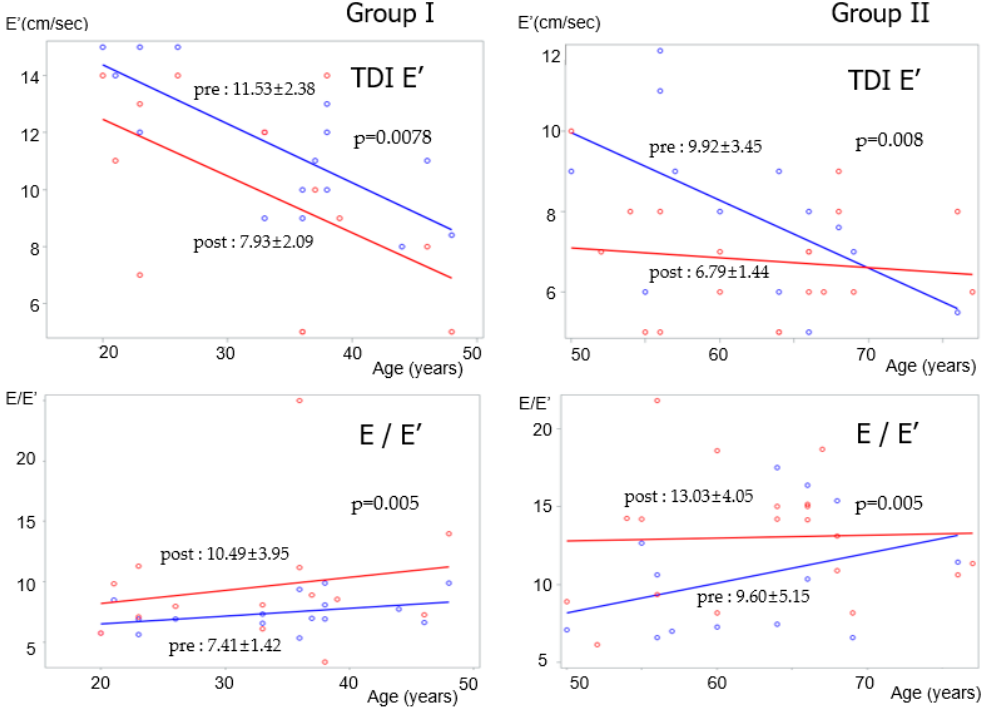
Figure 1. TDI E’ and E / E’ data as a function of age before and after atrial septal defect closure in Group I (N = 18) and Group II (N = 20). TDI: tissue Doppler imaging .